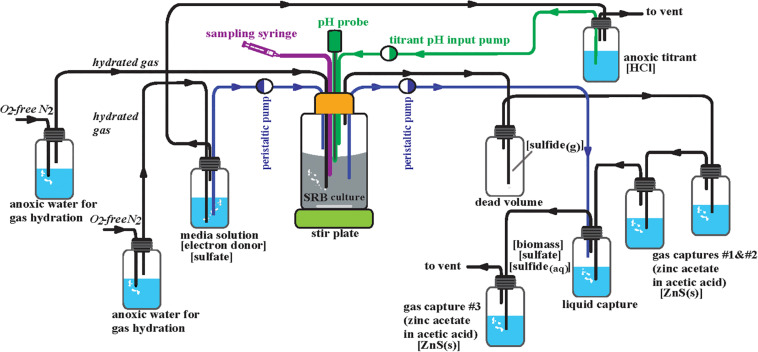
Schematic design for the chemostats.